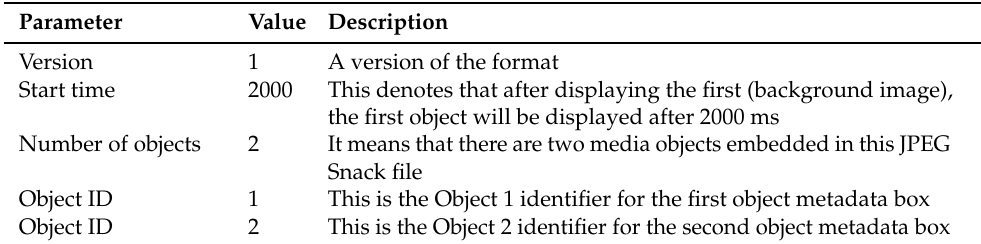
Table A1. Values of the JSDB parameters for the first example.